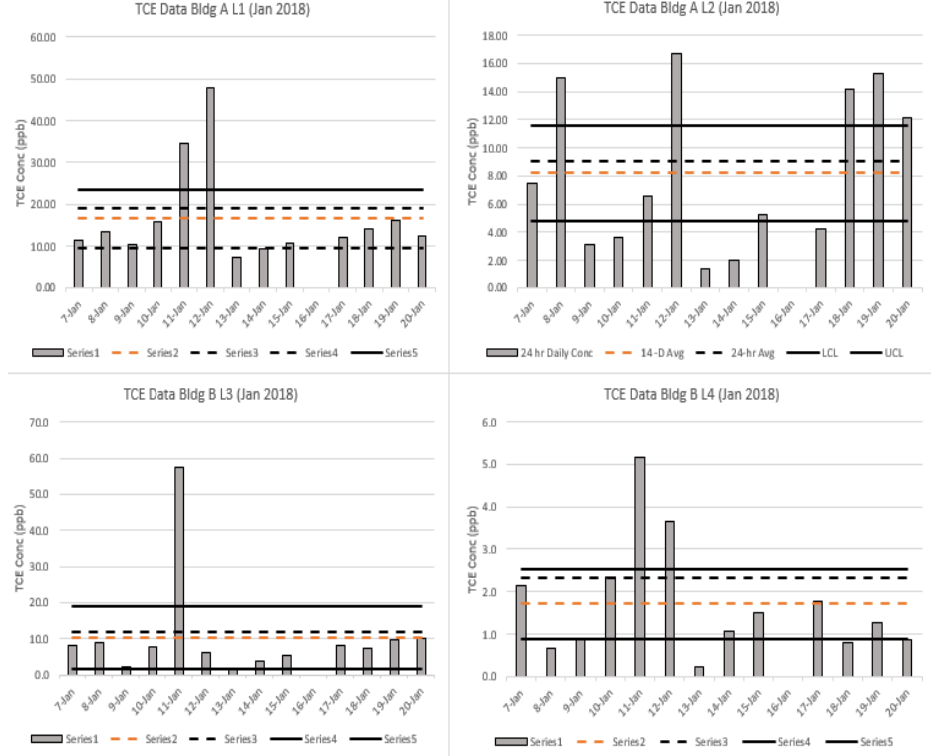
Figure 4. Comparative analysis of TCE concentrations from four locations (L1, L2, L3, L4) during a 2 wk period in January 2018 using traditional diaphragm (24 h) and capillary (14 d) controllers. Vertical gray bars represent daily concentrations, gray dashed lines represent the geometric mean (GM) of the daily (24 h) concentrations, solid black lines represent the 95% upper and lower confidence levels for the GM of the daily concentrations, and the orange dashed line represents the 14 d GM.